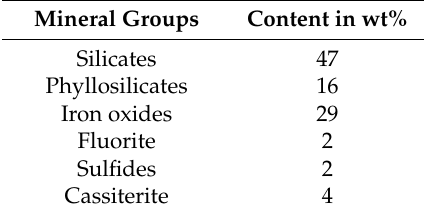
Table 1. Modal mineralogy defined by the Mineral Liberation Analyzer (MLA) of the input material.